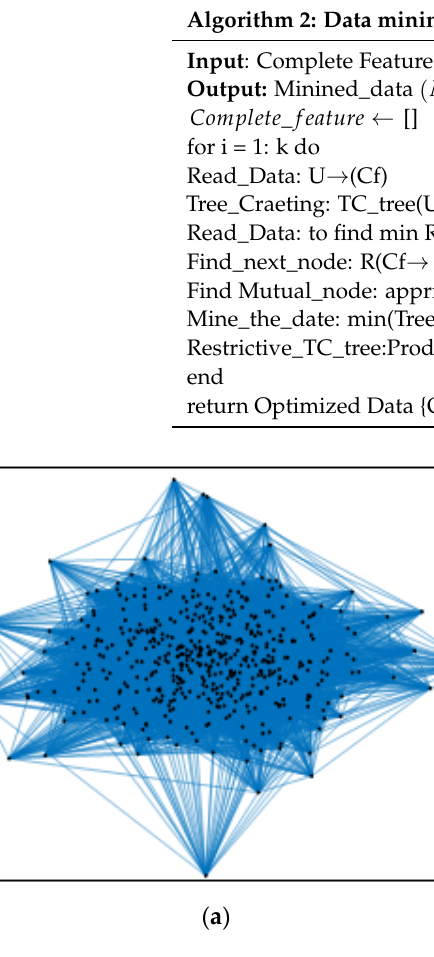
Figure 10. Optimized features mining results using graph mining framework of extracted features vector. ( a ) Features vector in graph representation and ( b ) after graph mining, the features vector representation.